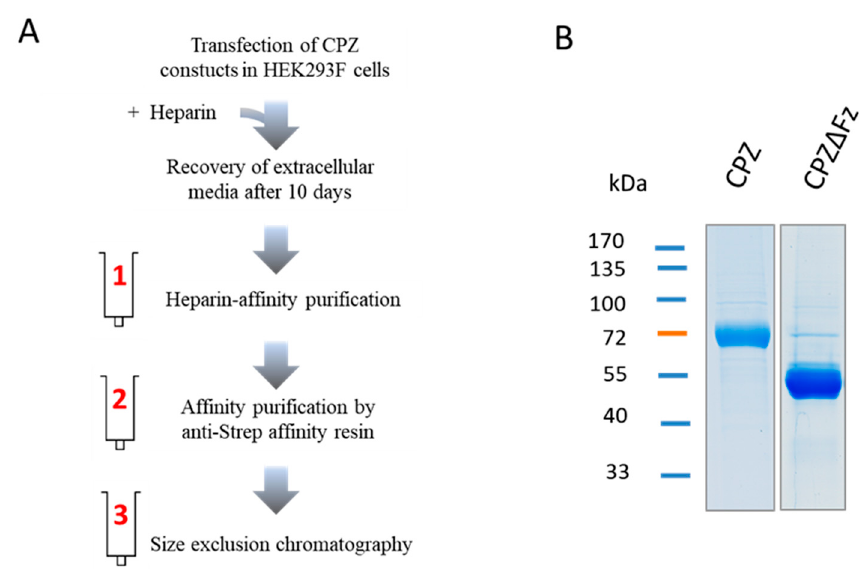
Figure 2. Recombinant expression and purification of human CPZ. ( A ) Schematic diagram of the experimental strategy used for the recombinant expression and purification of CPZ and CPZ ∆ Fz. Protein expression was performed by high-level transient transfection in suspension-growing HEK (Human Embryonic Kidney) 293F cells, followed by the addition of heparin at 48 h post-transfection. For protein purification, the extracellular medium was collected after 10-days incubation, and recombinant proteins were purified in three purification steps by heparin-a ffi nity chromatography, a ffi nity chromatography using anti-strep tag a ffi nity resin, and by size-exclusion chromatography; ( B ) SDS–PAGE showing the purity and size of the recombinant proteins.